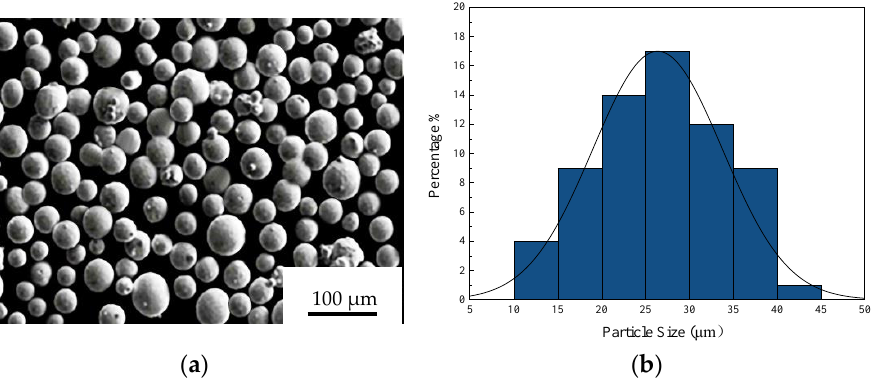
Figure 1. The 316L pellets and particle size: ( a ) SEM image of 316L pellets, ( b ) particle size distribution. Table 1. Chemical compositions of the as-used 316L stainless steel pellets. Element Content